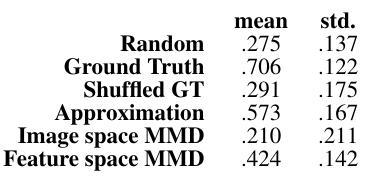
Table 3. SemSim scores for the domain pair Hannover (source)